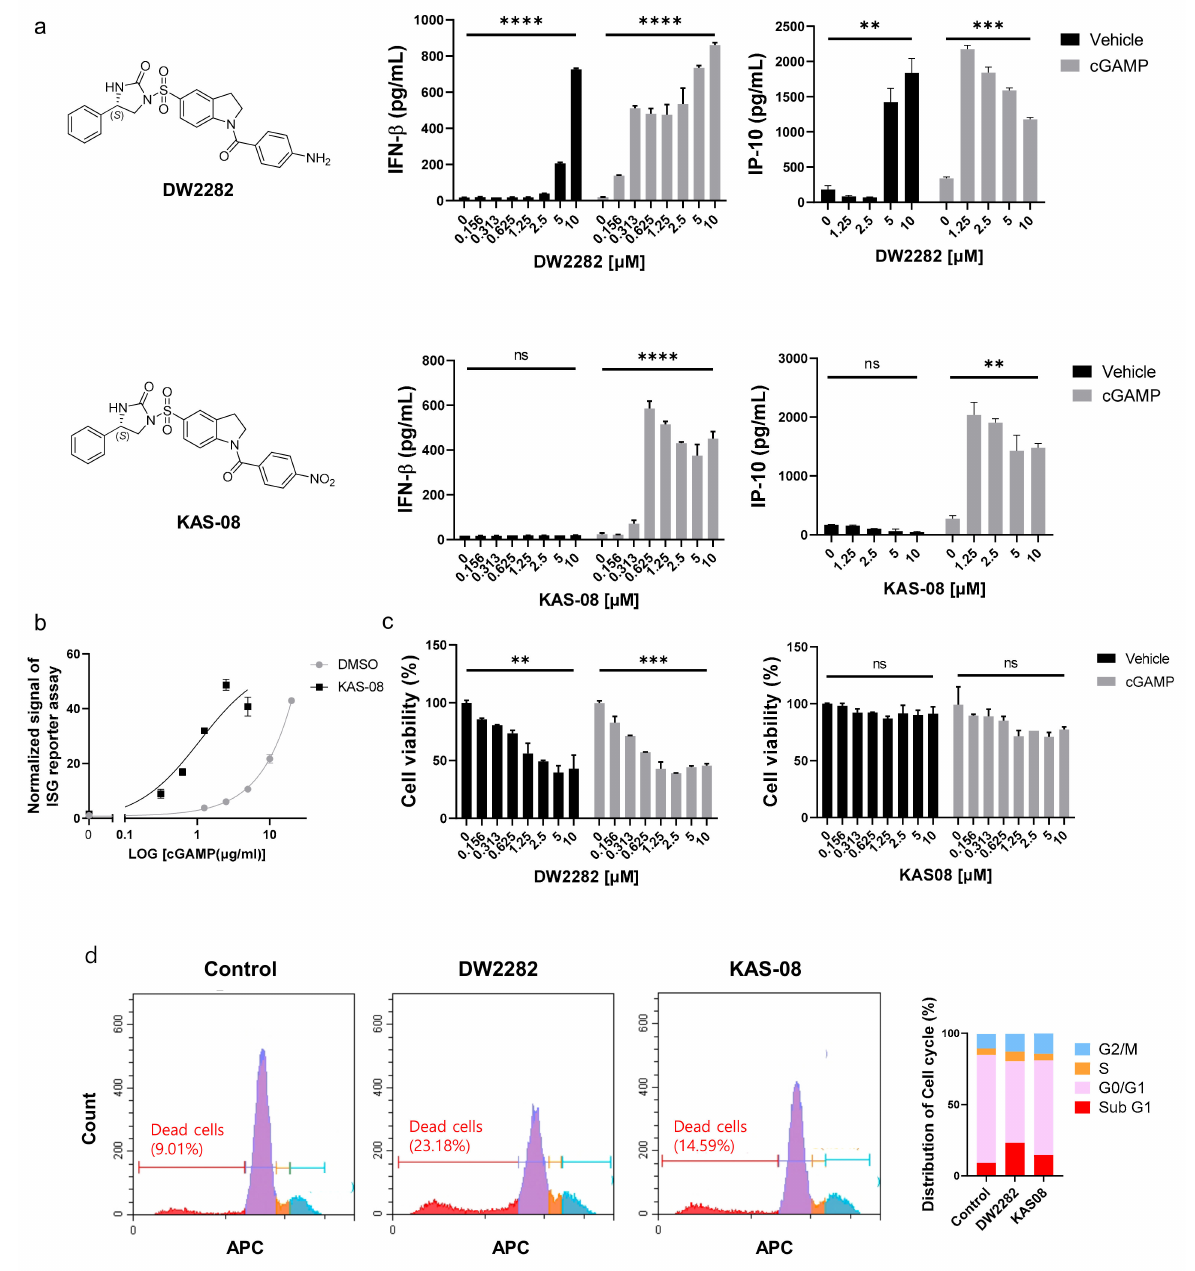
Figure 3. Differentiated mode-of-action between DW2282 and KAS-08 for boosting cGAMP-induced immunity. ( a ) Chemical structure of two compounds and ELISA analysis of IFN β and IP-10 by DW2282 ( up ) and KAS-08 ( down ) treatment in the absence or presence of cGAMP (1 µ g/mL) in THP-1 cells. ( b ) ISG reporter assay by titration of cGAMP in absence or presence of KAS-08 (2.5 µ M) in THP-1 cells. ( c ) Cell viability after treatment of DW2282 ( left ) and KAS-08 ( right ) for 24 h in THP-1 cells. Graphs show the mean and SD. **: p < 0.01, ***: p < 0.001, ****: p < 0.0001, and ns: non-significant by Student’s t -test. ( d ) Cell cycle analysis measured by FACS. THP-1 cells were treated by DW2282 (10 µ M) and KAS-08 (10 µ M) for 6 h. Histogram graphs ( left ) and the quantified result ( right